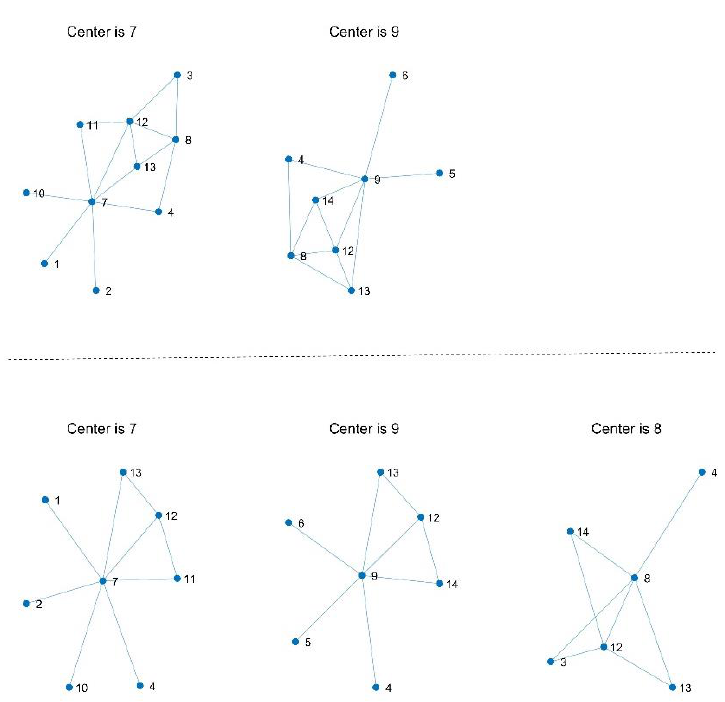
Figure 6. Influence of expert knowledge on subgraph decomposition.